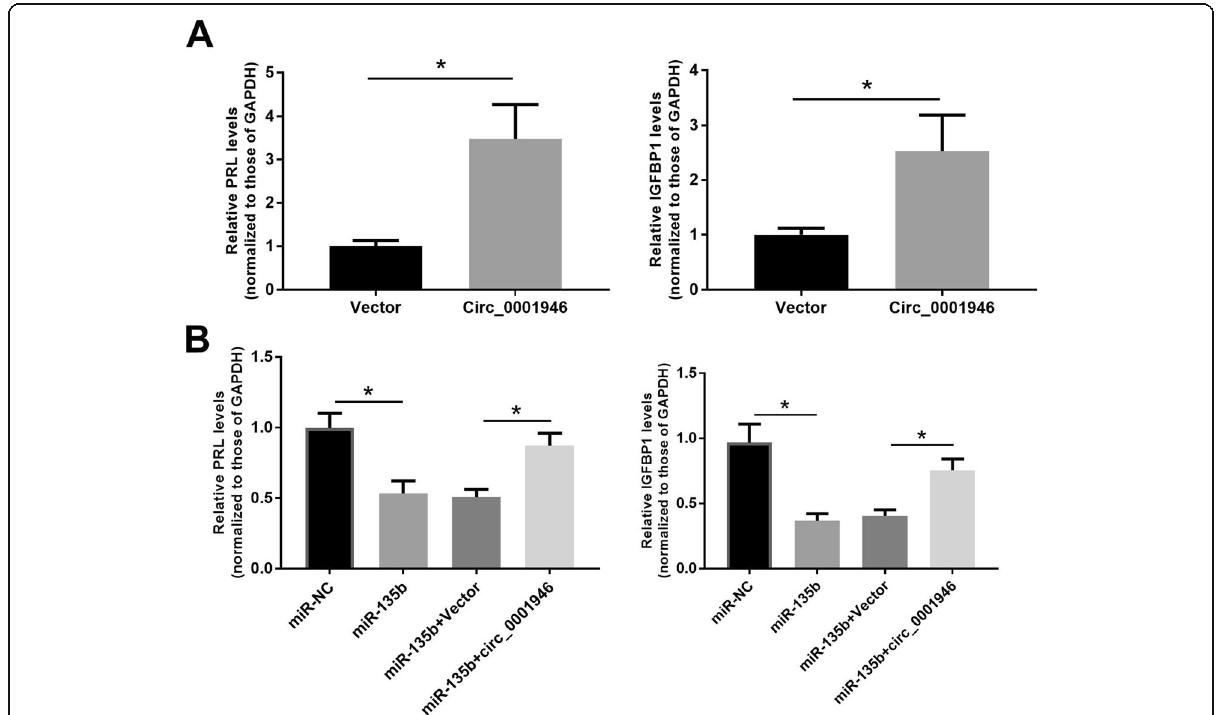
Fig. 5 Hsa_circ_001946 promoted decidualization by sponging miR-135b in T-HESCs. Cells were transfected with hsa_circ_001946 and/ or miR- 135b. a and b. Quantitative RT-PCR for IGFBP1 and PRL in the transfected cells. * P <